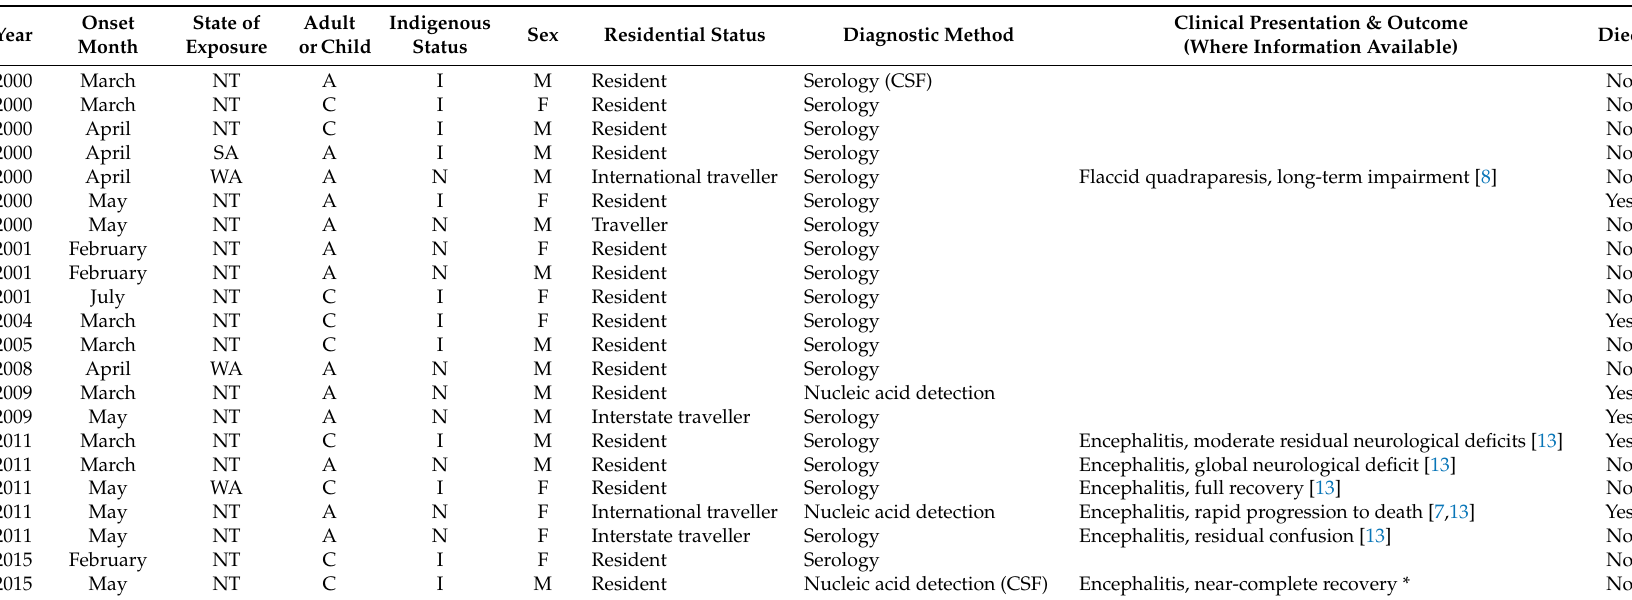
Table A1. Demographics of clinical Murray Valley encephalitis virus (MVEV) cases notified to the local Centre for Disease Control Northern